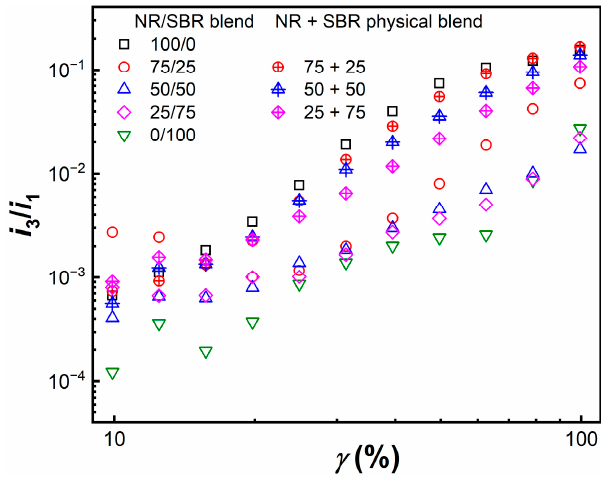
Figure 10. Relative third harmonic ( i 3 / i 1 ) as function of strain amplitude ( γ ) for NR/SBR blends and NR + SBR physical blends at 100 o C and 1 rad/s.